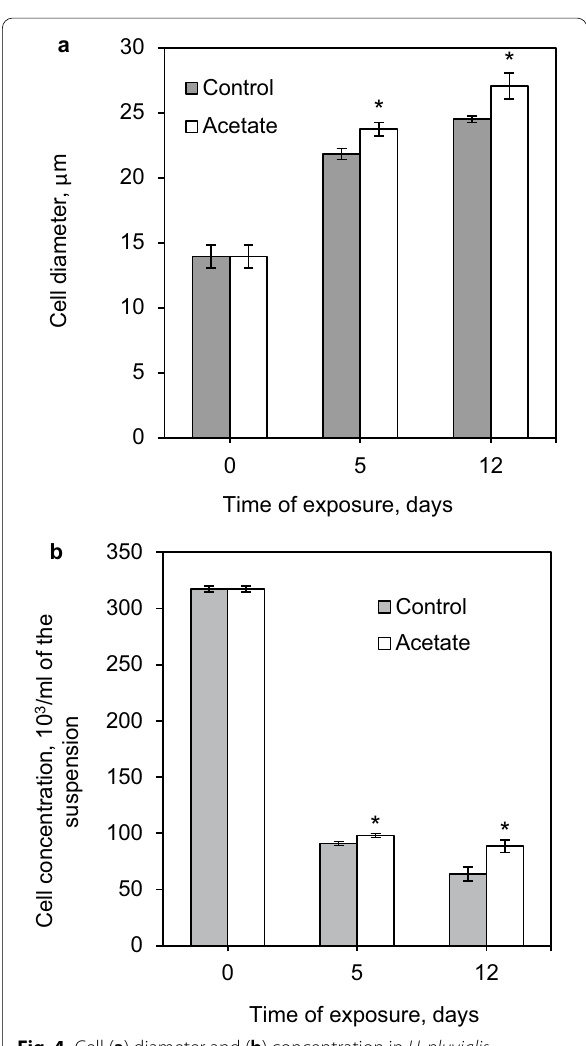
Fig. 4 Cell ( a ) diameter and ( b ) concentration in H. pluvialis suspension after 5 and 12 days of cultivation under stress conditions: hereinafter (*) indicates significant difference from the corresponding control ( p ≤